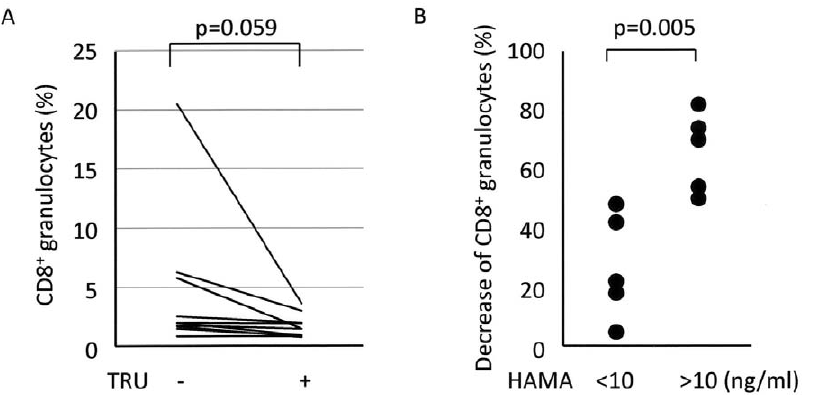
Figure 6. Involvement of HAMA in Fc c R-mediated trogocytosis. ( A ) Effects of HAMA blockade on Fc c R-mediated trogocytosis (n=10). Heparinized whole blood samples were added with or without 1 m l of HAMA inhibitor, TRU block, and then made to react with the PE-labeled anti- CD8 a (HIT8a) and FITC-labeled anti-CD15 (H198) Abs. After depletion of erythrocytes, these cells were subjected to FCM. PE-labeled mouse IgG1 and FITC-labeled mouse IgM were used as isotype-matched controls for HIT8a and H198, respectively. Student t -test for paired samples was applied for statistical analysis. ( B ) Difference in the inhibition rates of Fc c R-mediated trogocytosis by the HAMA inhibitor between HAMA high sera and HAMA low sera. The serum samples were divided into 2 groups, including HAMA high serum (more than 10 ng/ml, n=5) and HAMA low serum (less than 10 ng/ml, n=5). The decrease rates of CD8 + granulocytes by treatment with TRU block were calculated from the data presented in Figure 6A. Student t -test for unpaired samples was applied for statistical